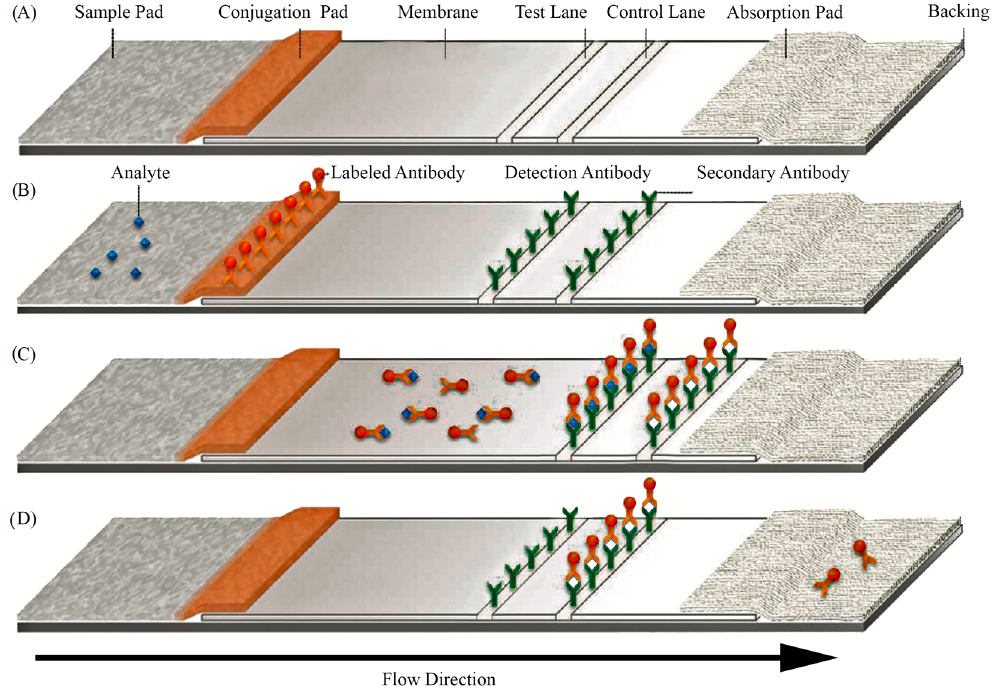
Figure 4. Overview of lateral flow assay (LFA) principle. ( A ) Physical components of a conventional LFA system; ( B ) Biological components present in a conventional LFA; ( C ) Upon addition of a positive sample, the labeled antibody interacts with the analyte and migrates by capillary action to the test lane, where the complex analyte-antibody is immobilized through the detection antibody. The control lane also immobilizes the labeled antibody; ( D ) In the absence of the target, the labeled antibody does not interact with the detection antibody and is immobilized in the control lane, indicating negative detection of the analyte. Adapted from [90].